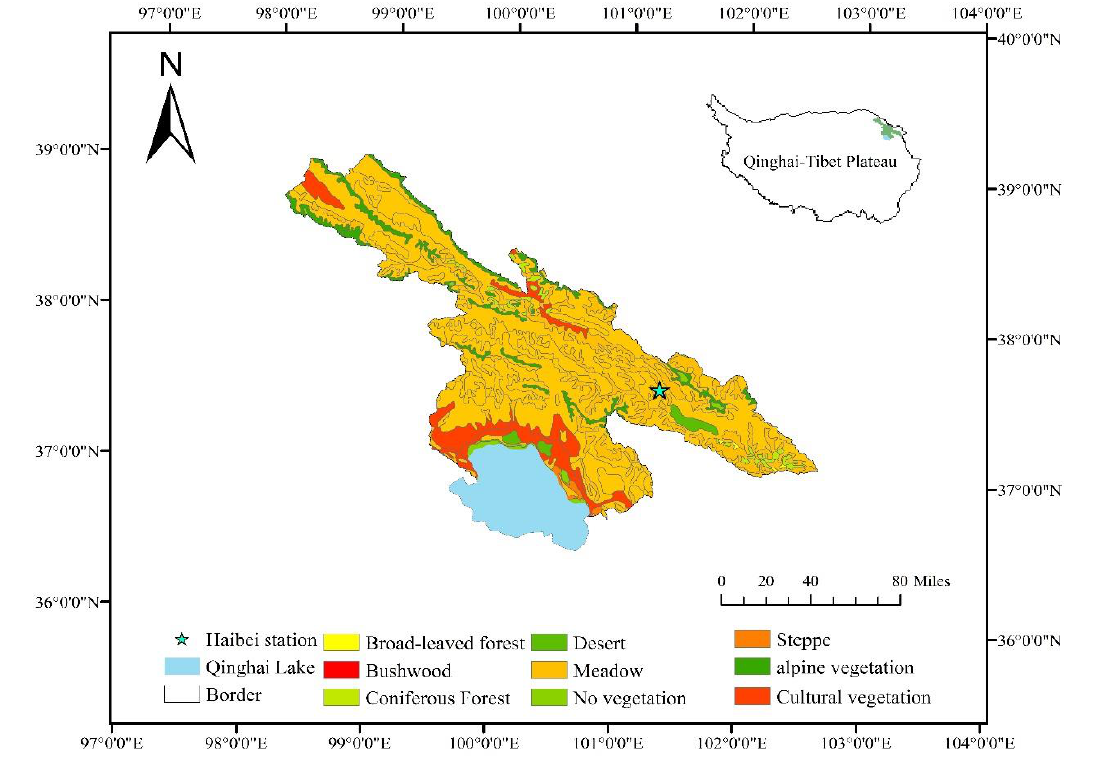
Figure 1. Geographical location of the study area.